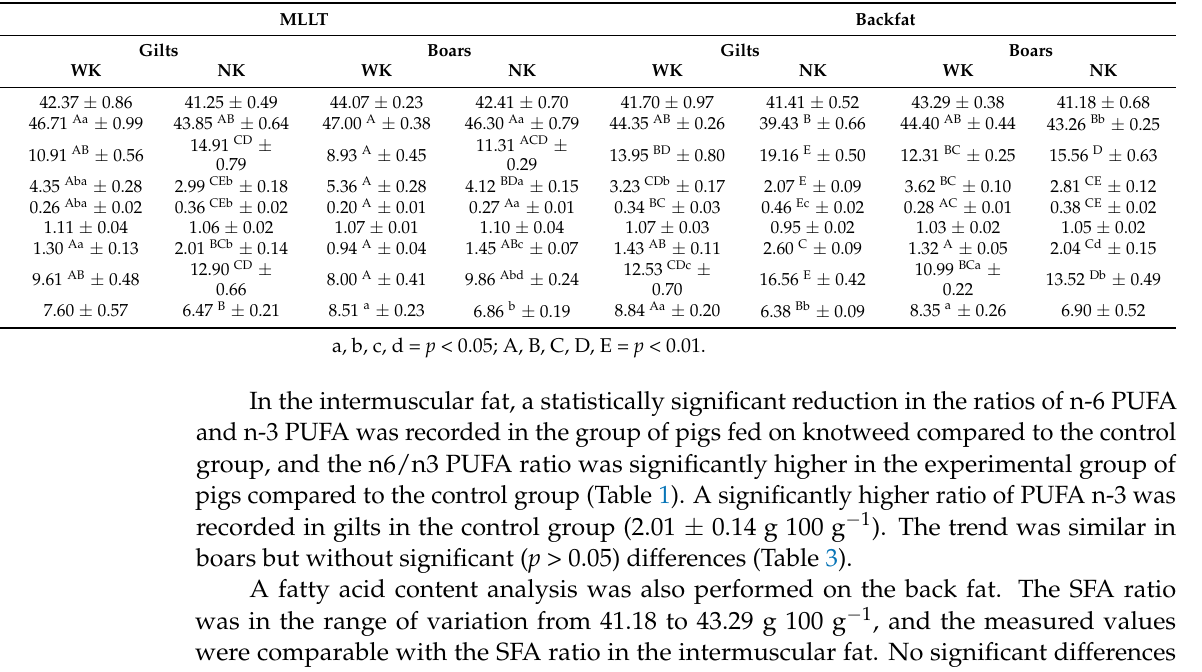
Table 3. The composition of fatty acids in the intramuscular fat MLLT and in the depot fat of pigs. The experimental group of pigs (WK) and the control group of pigs (NK) separated according to sex. (Means ± SEM g 100 g − 1